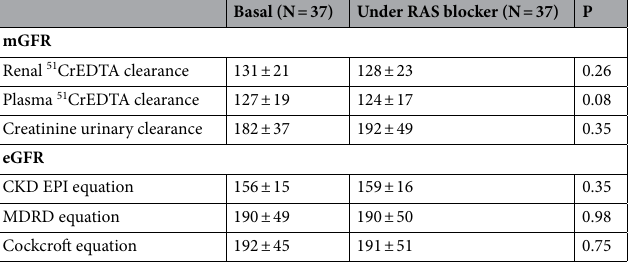
Table 2. Comparison of mGFR and eGFR values before and under ACEI treatment. mGFR values, CKD EPI and MDRD equations are expressed in ml/min/1.73 m 2 . Cockcroft equation is expressed in ml/min.